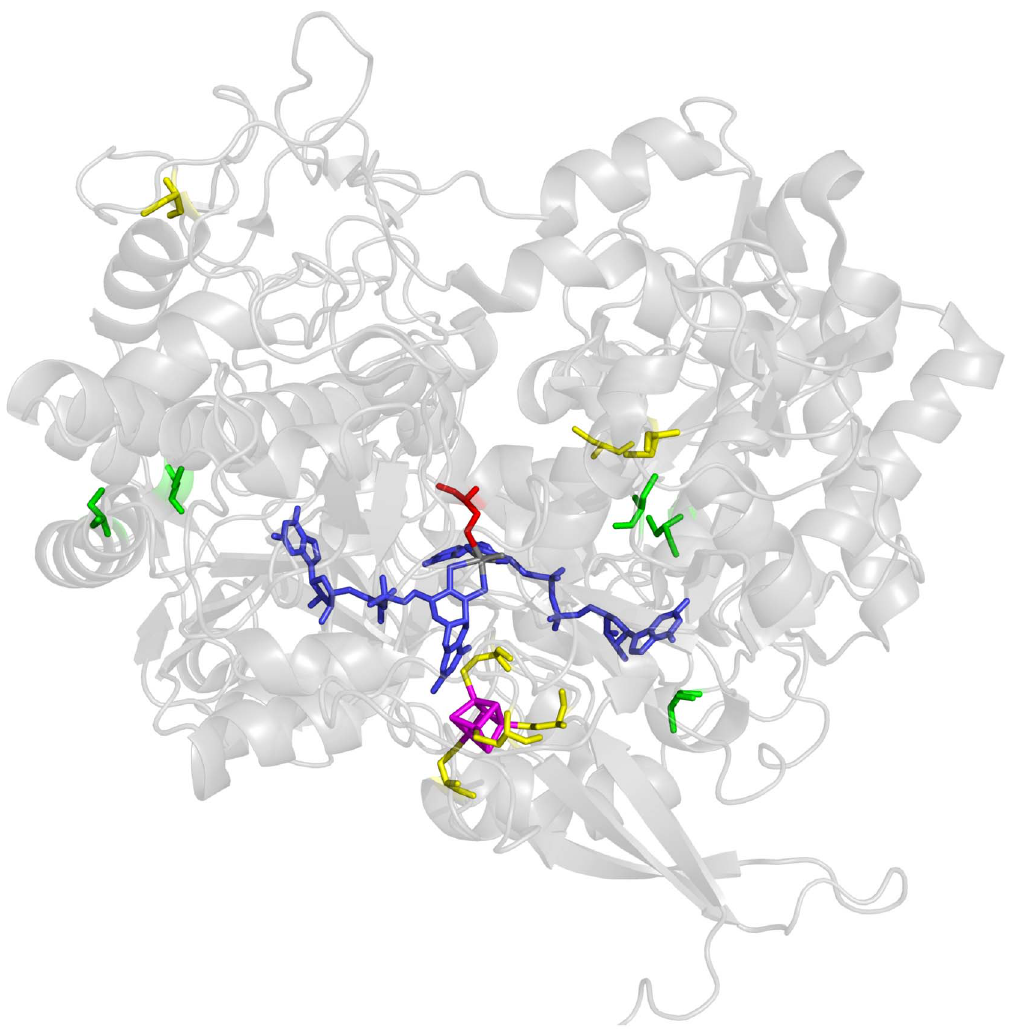
Figure 5. Schematic representation of the structure of the catalytic subunit FdnG of Fdh-N from E.coli (PDB entry: 1KQF). The protein backbone of FdnG (alpha subunit) is shown as a ribbon stucture. Modified cysteines are shown in green, unmodified cysteines in yellow. Sec-196 is presented in red. The molybdopterin guanosine dinucleotide cofactor is shown in blue and the [4Fe4S]-cluster is represented in magenta.